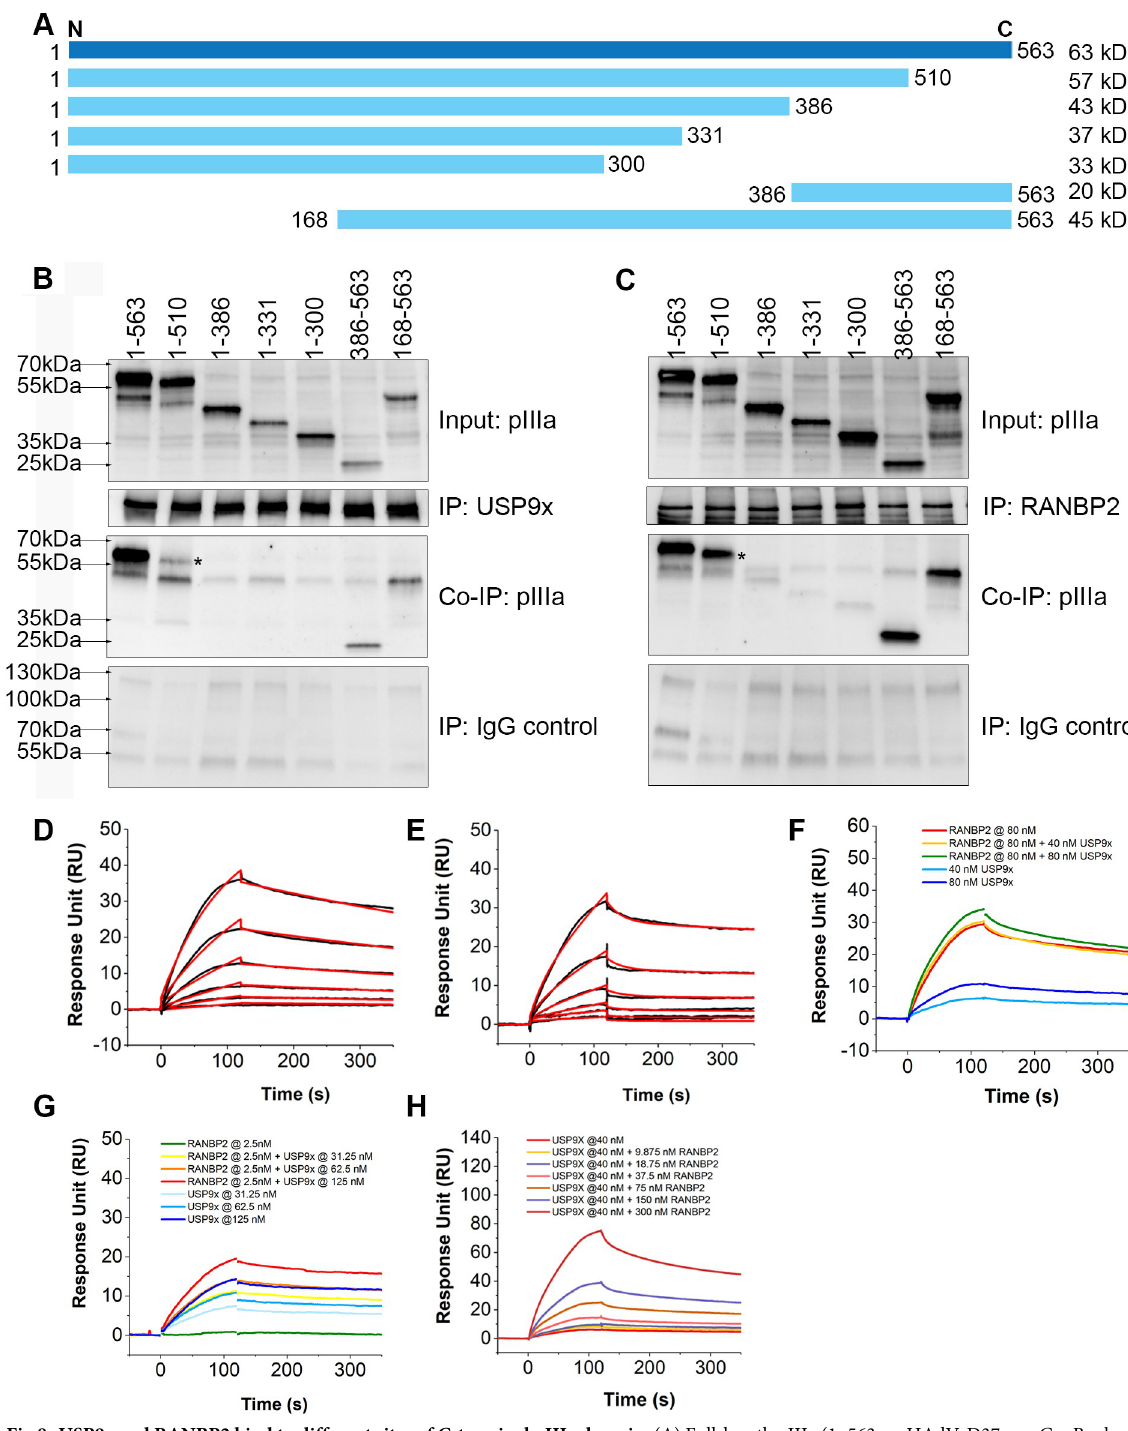
Fig 8. USP9x and RANBP2 bind to different sites of C-terminal pIIIa domain. (A) Full-length pIIIa (1–563 aa; HAdV-D37, per GenBank: DQ900900) and six partial pIIIa deletion mutants were constructed in a pCDNA 3.1 vector backbone. After transfection of HEK293 cells with the pIIIa constructs, immunoprecipitations were performed using antibodies against USP9x (B) and RANBP2 (C). Both USP9x and RANBP2 interacted with full-length pIIIa (1–563 aa), and pIIIa fragments 386–563 aa, and 168–563 aa. The pIIIa coprecipitation was weak for fragment 1–510 (asterisk: � ). (D) SPR sensorgrams of USP9x with pIIIa. Black curves are the sensorgrams and red curves are the fitted cycle. Two-fold series of dilutions of USP9X ranging from 7.8 nM to 250 nM were injected with a 2 min injection time and 230s dissociation time. The affinity was K D = 32.01 ± 4.92 nM, K on = 3.717x10 4 ± 120 (1/Ms) K off = 1.19x 10 − 3 ± 5.9x10 -6 (1/s). (E) SPR sensorgrams of RANBP2 with pIIIa. Two-fold